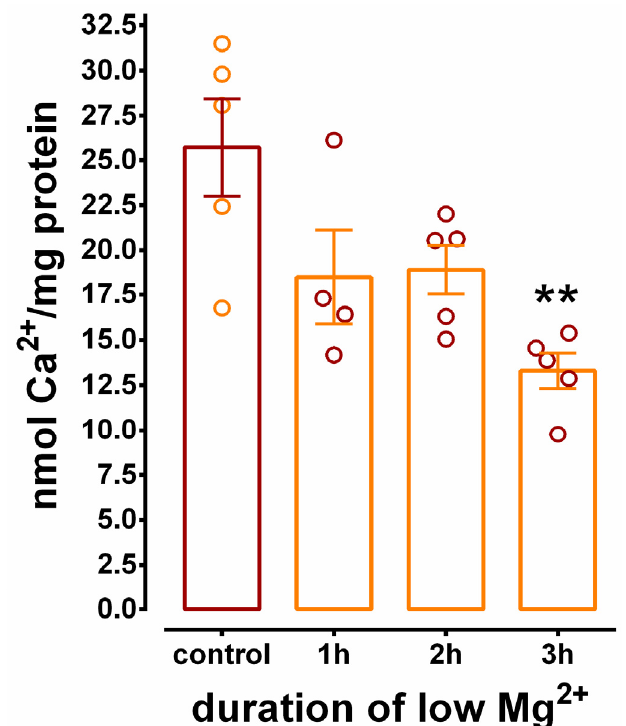
Figure 5. The effect of low Mg 2+ exposure duration of mixed hippocampal cultures on SERCA activity measured at 150 min of Ca 2+ uptake. Homogenates were isolated acutely from N+G cultures incubated in either control solution for 3 h or low Mg 2+ solution for 1, 2, or 3 h and standard Ca 2+ uptake reactions were performed as described under Materials and Methods. Activity was determined after 150 min of Ca 2+ uptake. One way ANOVA revealed that incubation in low Mg 2+ solution significantly inhibited Ca 2+ uptake ( p = 0.004, n = 5 for all except 1 h, n = 4). Tukey post-hoc analysis revealed that 3 h of incubation in low Mg 2+ was significantly different than 3 h of incubation in control (** p < 0.01).